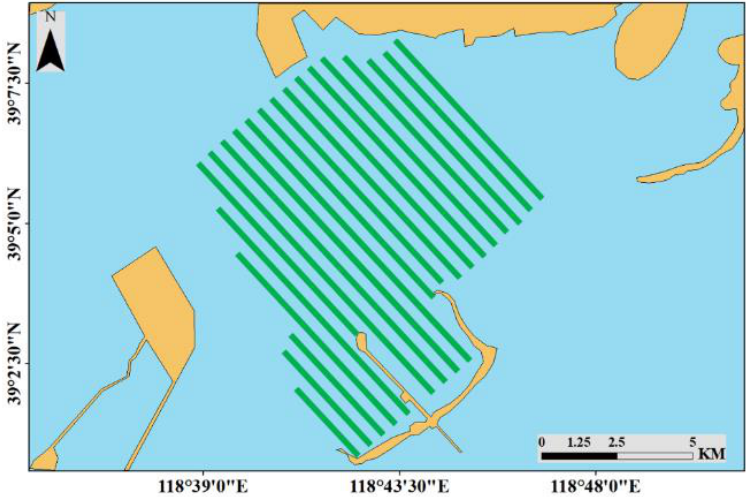
Figure 2. The ship route, with a spacing of ~500 m, for the acoustic survey of the seagrass distribu- tion.